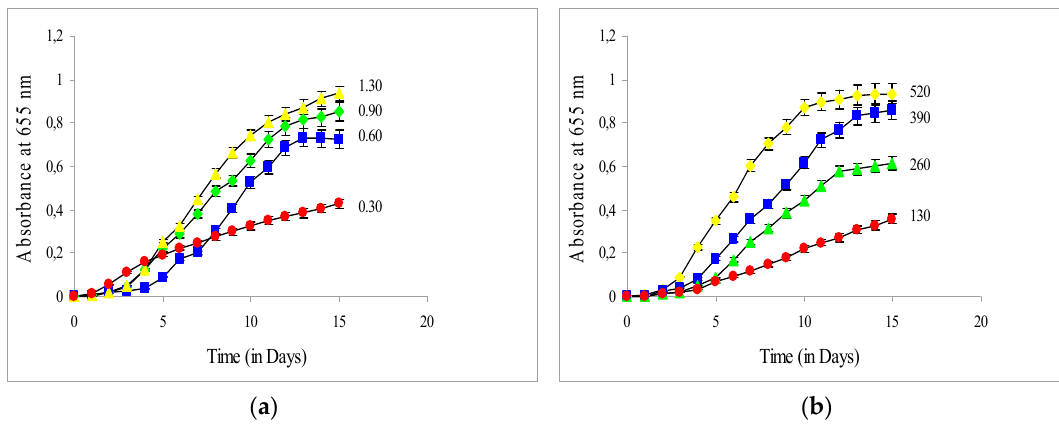
Figure 2. ( a , b ) Growth curves of C. vulgaris cultivated at four different ratios (I 420–520 /I 580–680 ) ( a ) and at four different artificial irradiations with white and red LED lamps in the bioreactor (in μ mol photons m − 2 s − 1 ) ( b ). The error bars represent the standard deviation of the means. Table 3. Specific growth rates ( μ exp ) in exponential growth phase (in d − 1 ) and biomass (P b ), lipid (P l ), and protein (P p ) productivities (in g L − 1 d − 1 ) of C. vulgaris cultivated at four different ratios (I 420–520 /I 580–680 ) and at four different light intensities with white and red LED lamps in the bioreactor. Growth Rate (in d − 1 ) and